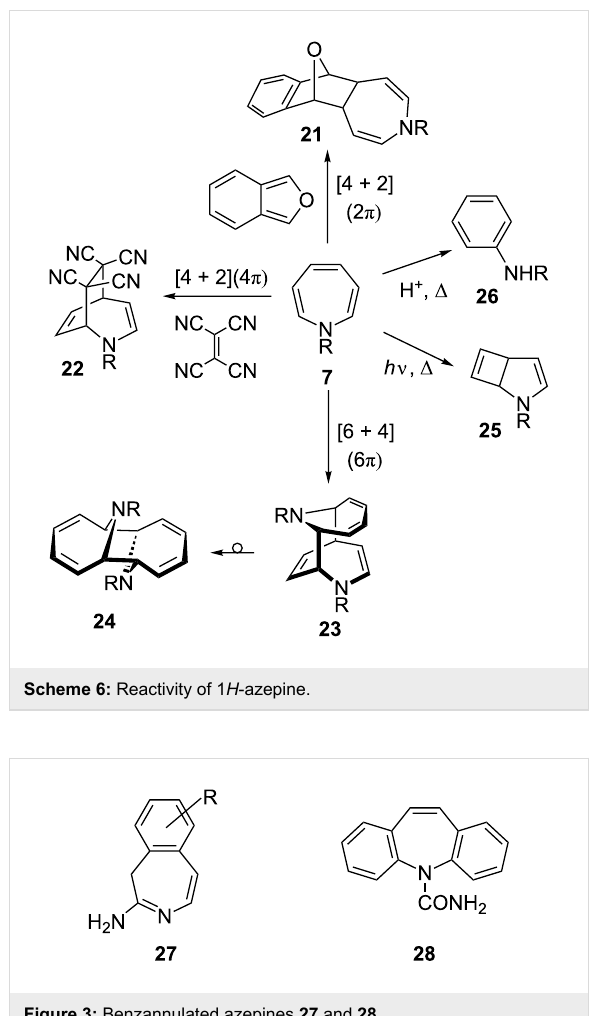
3 H -benzophosphepine, 32 ) [7,102-107]. The single-crystal X-ray structure analysis of phenyl-substituted phosphepine